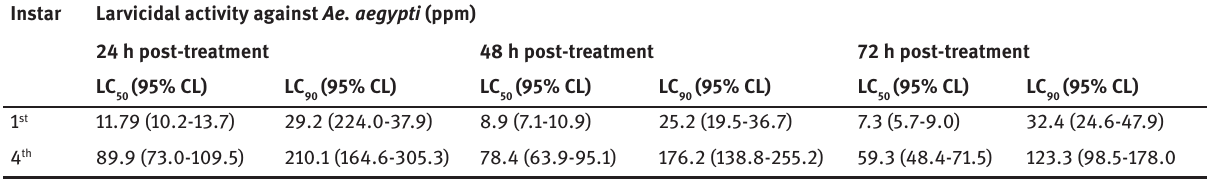
Table 1: Toxicity of Veratrum lobelianum extract against Aedes aegypti larvae.